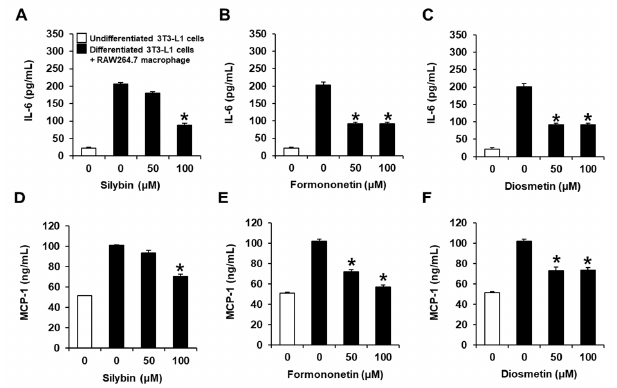
Figure 3. Inhibitory effects of silybin, formononetin, and diosmetin on the production of interleukin (IL)-6 and monocyte chemoattractant protein (MCP)-1 in co-cultures of 3T3-L1 and RAW264.7 cells. Analysis of the proinflammatory cytokine IL-6 production in co-cultures of 3T3-L1 and RAW264.7 cells treated with the indicated concentrations of ( A ) silybin, ( B ) formononetin, and ( C ) diosmetin. Analysis of the proinflammatory cytokine MCP-1 production in co-cultures of 3T3-L1 and RAW264.7 cells treated with the indicated concentrations of ( D ) silybin, ( E ) formononetin, and ( F ) diosmetin. In individual experiments, each treatment condition was set up in quadruplicate, and each experiment was repeated three times independently (* p < 0.05 compared to untreated cells, Kruskal–Wallis non-parametric test). Data are represented as the mean ± SEM. 2.3. Inhibitory Effects of Flavonoids on the Adipogenesis- and Inflammation-Associated Proteins in Co-Cultures of 3T3-L1 and RAW264.7 Cells Consistent with the inhibition of extracellular lipid accumulation and proinflamma- tory cytokines, silybin (100 µM), formononetin (50 and 100 µM), and diosmetin (50 and 100 µM) decreased the protein expression levels of peroxisome proliferator-activated re- ceptor- γ (PPAR γ ), CCAAT/enhancer-binding protein (C/EBP)- α , C/EBP β , inducible nitric oxide synthase (iNOS), and cyclooxygenase-2 (COX-2) (Figure 4). These results indicate that silybin, formononetin, and diosmetin inhibit adipogenesis-associated proteins (PPAR γ , C/EBP α , and C/EBP β ) and inflammation-associated proteins (iNOS and COX-2), thus, silybin, formononetin, and diosmetin may ameliorate inflammatory crosstalk be- tween macrophages and adipocytes.